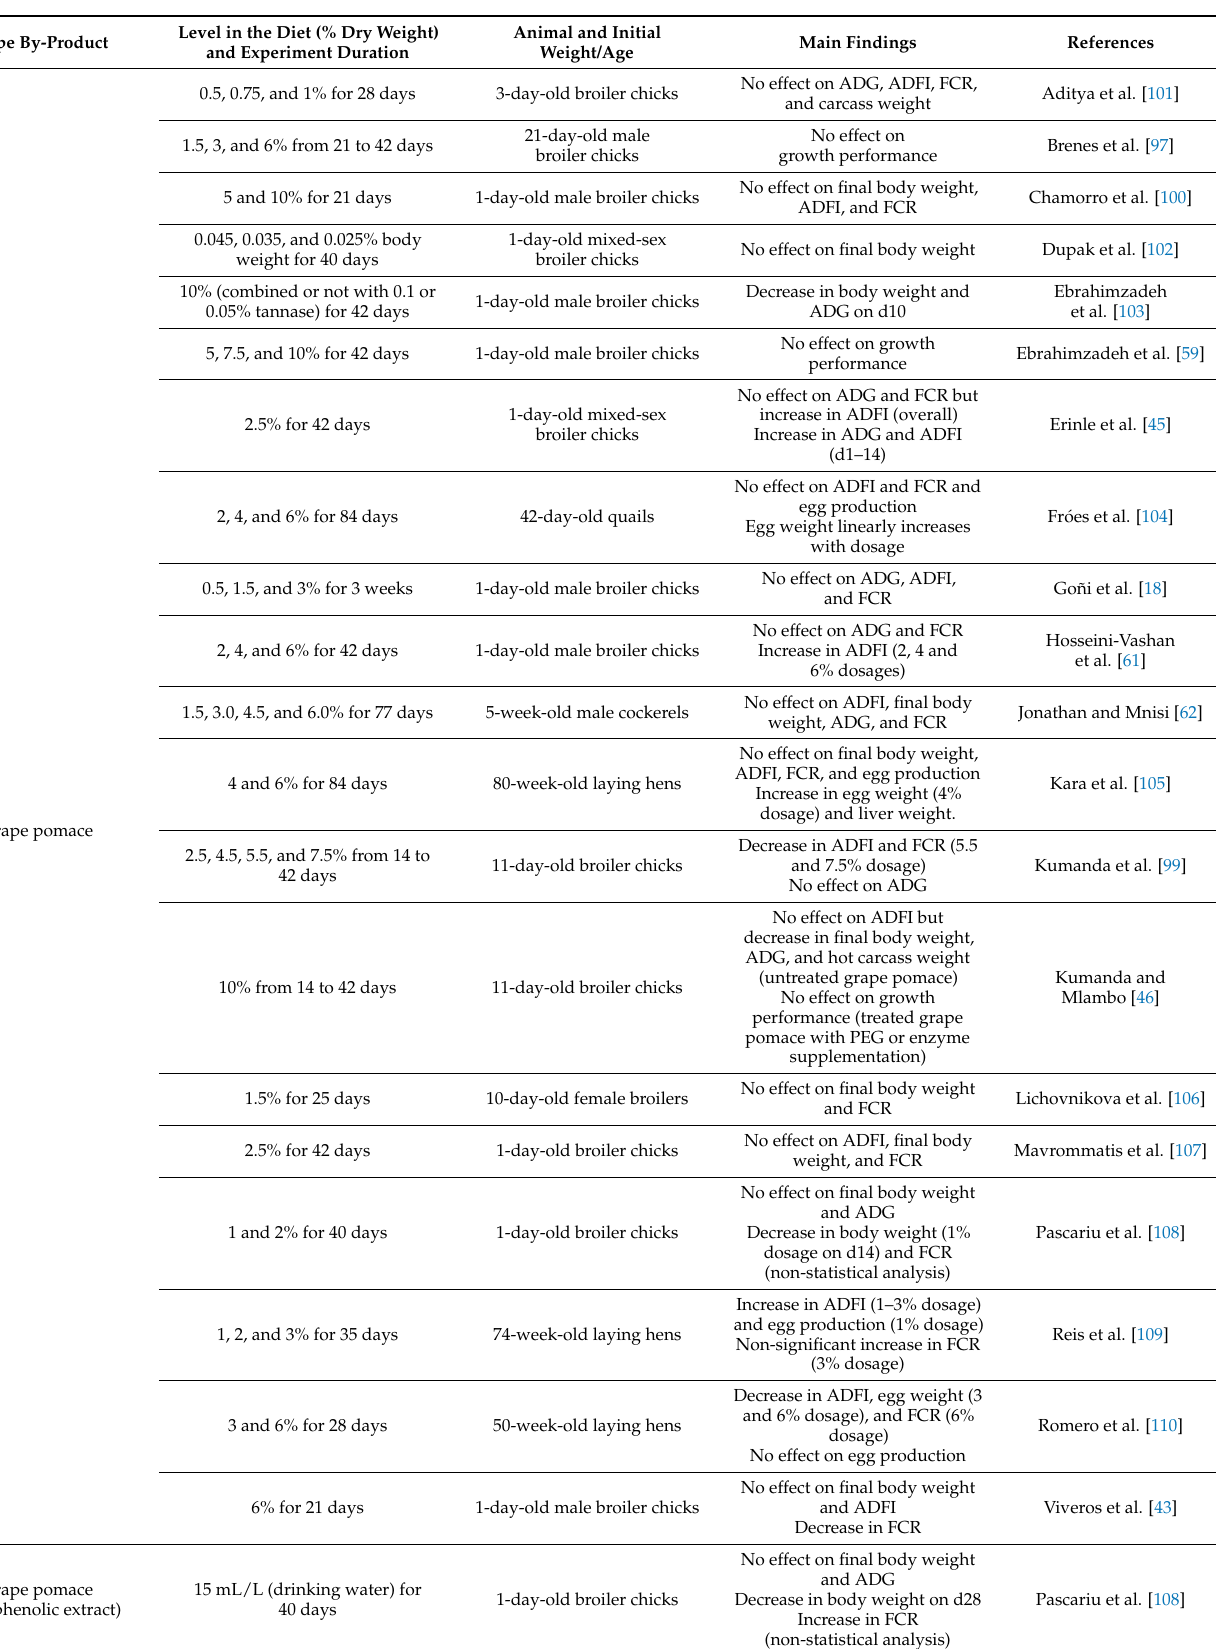
Table 4. Literature review on the effects of dietary inclusion of grape by-products on production performance of